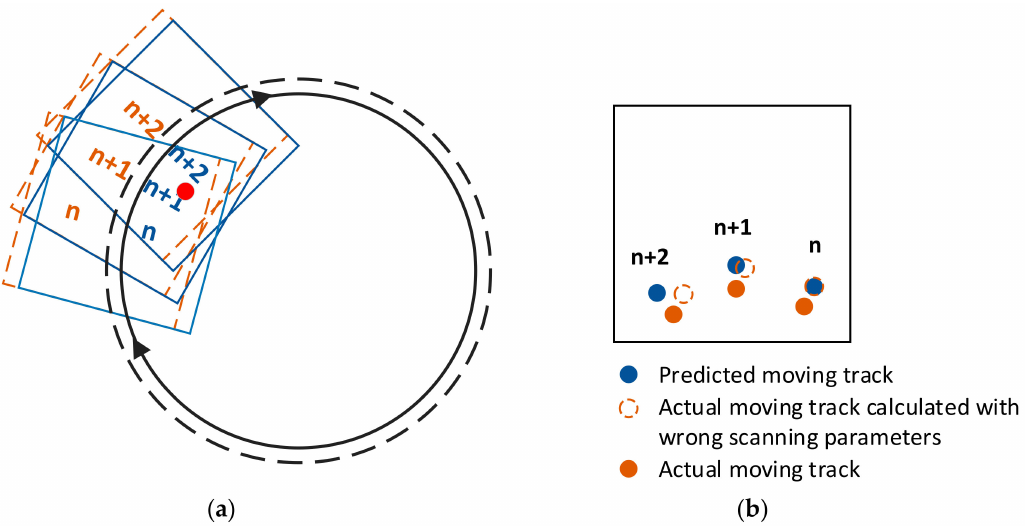
Figure 12. ( a ) Comparison between sub-apertures under ideal scanning settings and actual scanning path; ( b ) Description of how scanning path departures a ff ect the stitching work.